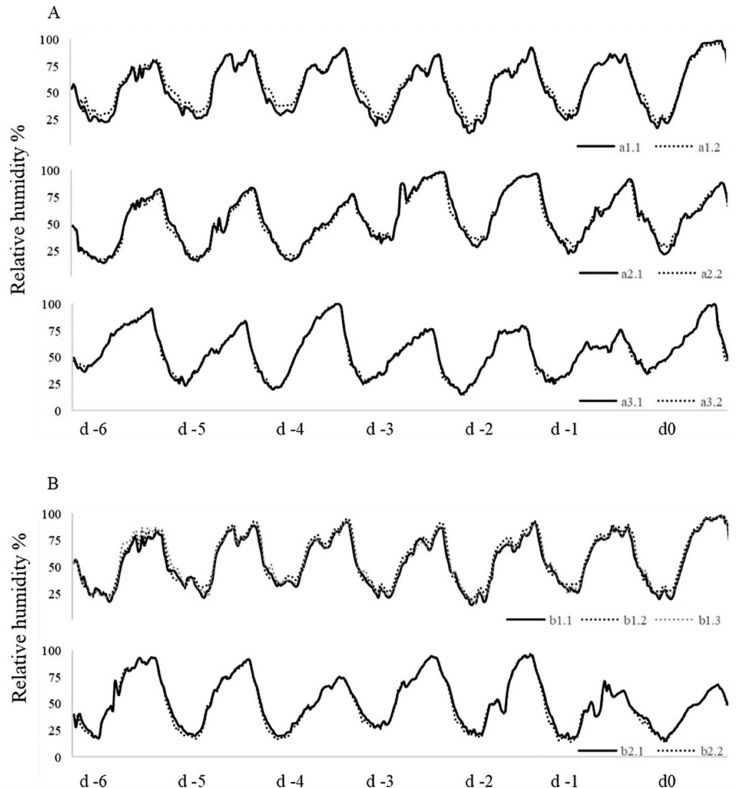
Figure 2. Average daily relative humidity (%) over the last six days before harvest for each variety and treatment. Continuous lines correspond to control cultivars while dotted lines represent treatments. The image shows ( A ) the use of elicitors) and ( B ) canopy management systems.